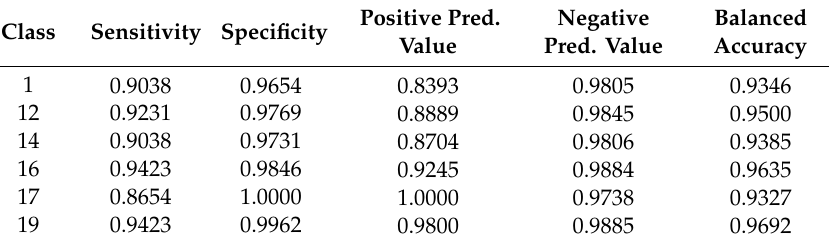
Table 8. Statistics by class for zones 1, 12, 14, 16, 17 and 19.